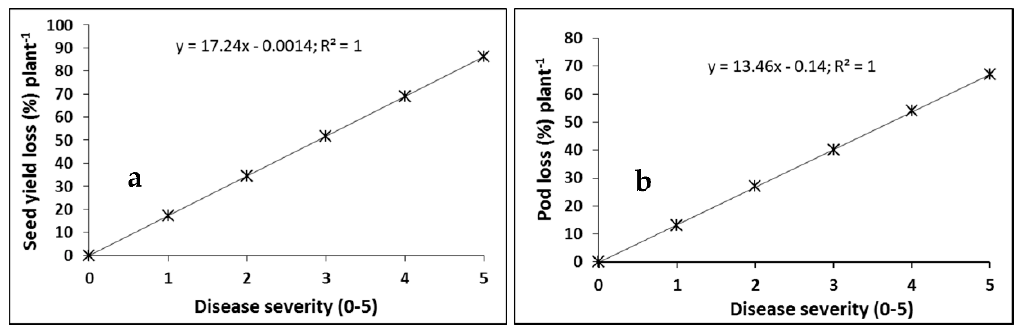
Table 4. Median rank and estimated relative effects (p i ) of pyraclostrobin application (92.5 g·a.i.·ha − 1 ) Figure 3. Relationship between blackleg severity and yield loss in the cultivar “Westar” under field Figure 3. Relationship between blackleg severity and yield loss in the cultivar “Westar” under field on blackleg severity on the canola hybrid “1950RR” at Edmonton (Crop Diversification Centre conditions at Edmonton, and Namao, Alberta, in 2013–2015. Each point represents the mean of conditions at Edmonton, and Namao, Alberta, in 2013–2015. Each point represents the mean of four North; CDCN) in 2014 and 2015, and at Namao, Alberta, in 2014. four replications ˆ five site-years. The yield loss data were derived using the y-intercept in the replications × five site-years. The yield loss data were derived using the y-intercept in the equation equation averaged over 5 site-years in Figure 2b, which was taken as an estimation of the yield of the averaged over 5 site-years in Figure 2b, which was taken as an estimation of the yield of the cultivar cultivar “Westar” in the absence of disease. The data points were transformed into the percentage of “Westar” in the absence of disease. The data points were transformed into the percentage of that that yield (% maximum yield). yield (% maximum yield).